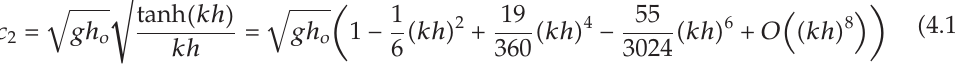
Also, when σ (cid:7) O (cid:2) μ (cid:3) , the formula for the wave celerity (cid:2) 4.17 (cid:3) is similar to those